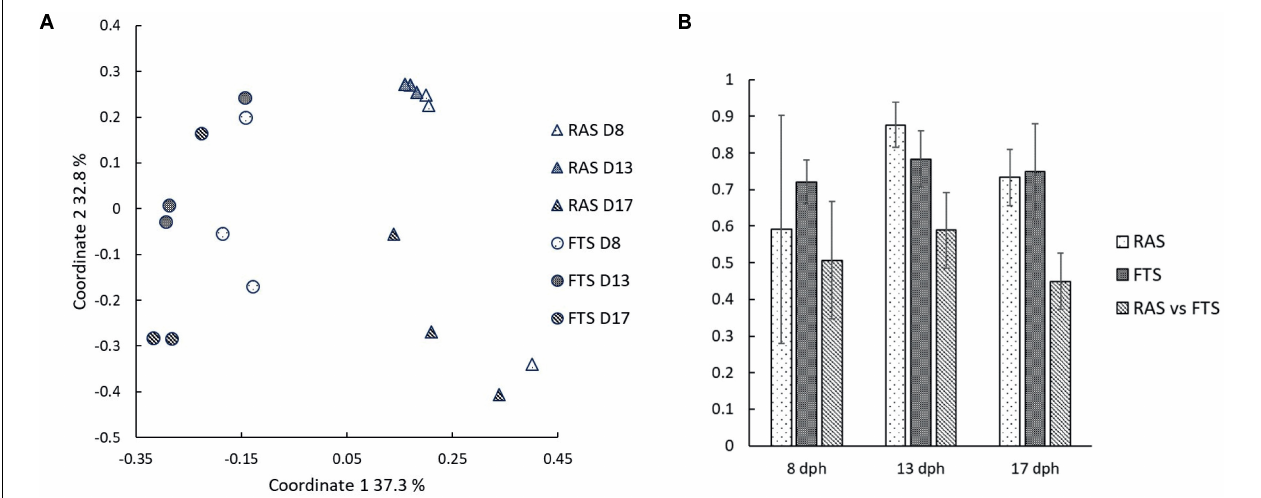
FIGURE 5 | (A) Principal coordinates plot based on Bray–Curtis similarities for comparison of larval microbiota in RAS and FTS sampled on 8, 13, and 17 dph. (B) Average Bray–Curtis similarities for comparisons of larval microbiota within systems and between systems at 8, 13, and 17 dph. Error bars are standard